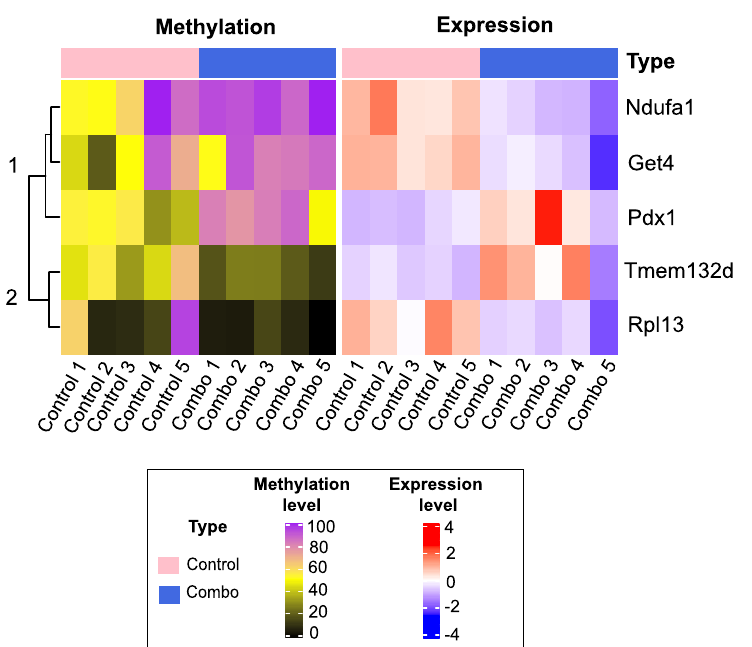
Figure 6. Correlation of DEGs and DMGs in the combination treatment group. ( a ) Venn diagram representing unique and overlapping differentially expressed genes (DEGs) and differentially methylated genes (DMGs) in the combination (BSp + GTPs) treatment group. ( b ) Scatter plot for 39 genes which are differentially expressed and methylated. The y-axis represents the methylation difference across 39 genes (dots in red color) and x-axis represents log 10 FC. Out of 39 transcripts, 2 genes ( Tmem132d and Pdx1 ) were up-regulated and hypomethylated and 3 genes ( Ndufa1 , Rpl13 and Get4 ) were downregulated and hypermethylated. ( c ) Heatmap representing overlapping 5 up- and downregulated genes in the combination (BSp + GTPs) treatment group based on q value. Each row corresponds to differentially expressed and differentially methylated transcripts and each column represents biological replicates in control (N = 5) and the combination (N = 5) treatment group. Blue color denotes lower expression levels and red color denotes higher expression